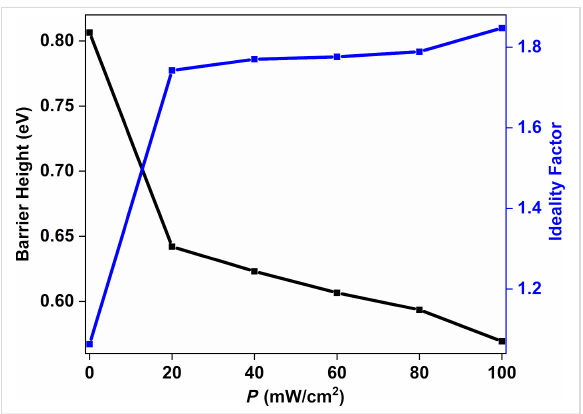
Figure 5: The values of n and ϕ b of the Au/CuNiCoS 4 /p-Si photodiode as functions of the illumination power density.